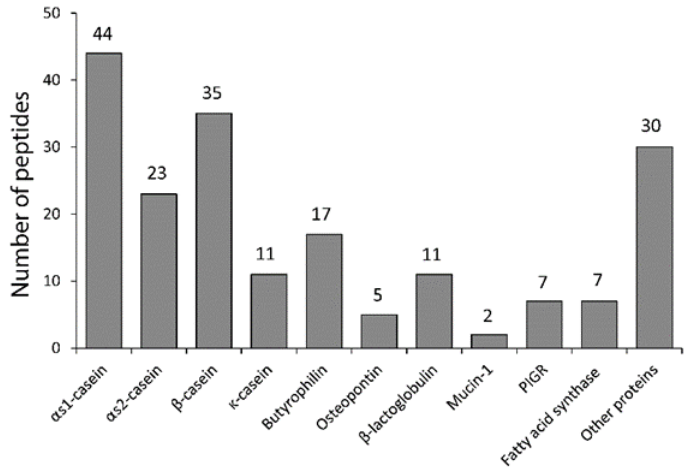
Figure 1. Number of peptides identified from different milk proteins. PIGR, polymeric immunoglobulin receptor.